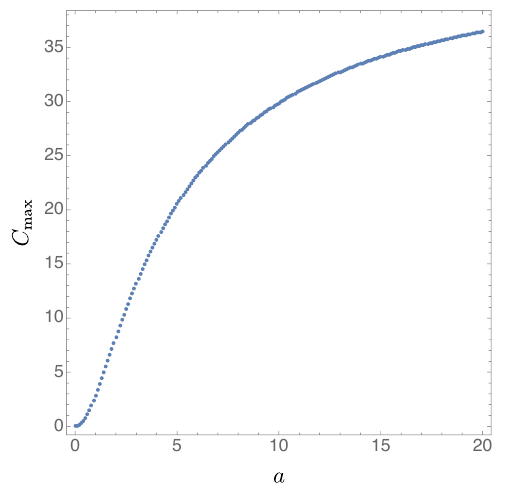
Figure 9 . C max as a function of a for boundary metrics without ergoregions: there is no indication that the metric is becoming singular at any (cid:12)nite value of a